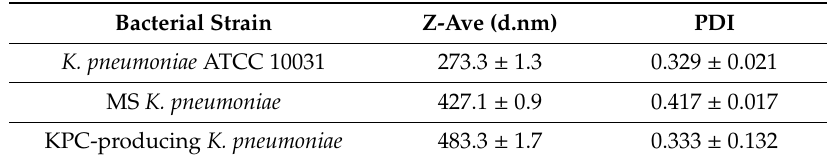
Table 2. Dynamic light scattering (DLS) analysis measurements of the Z-average size (Z-ave) and